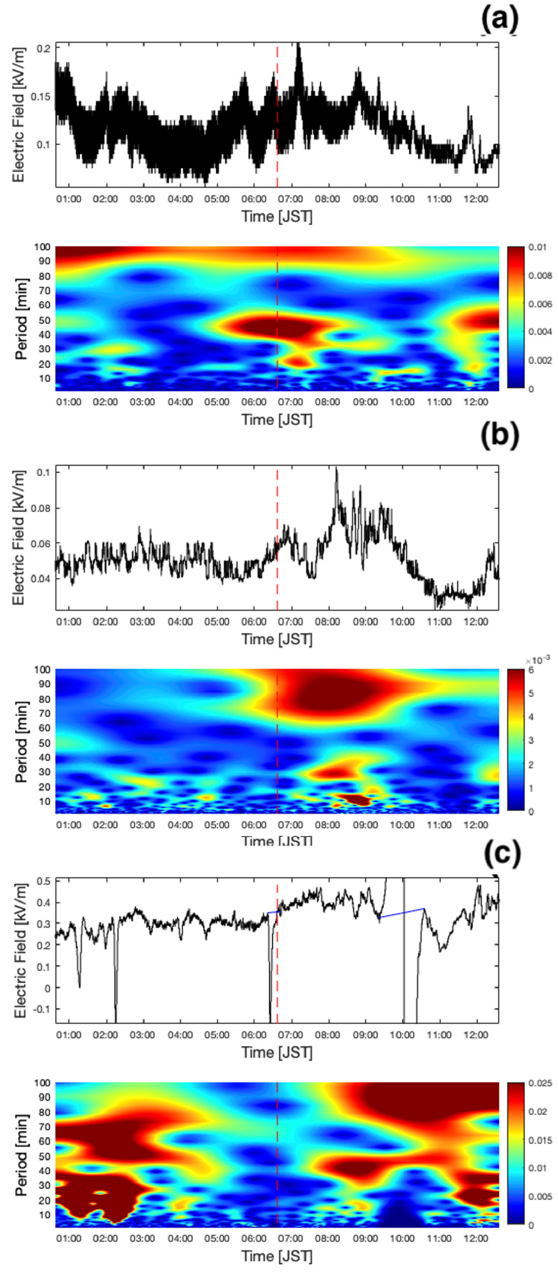
Figure 3. Time series and dynamic periodograms of the AEF with the period from up to 100 min in the interval from 6 h before to 6h after EQ1: ( a ) Chofu (CHF), ( b ) Kakioka (KAK), and ( c ) Iwaki (IWK). It was preferable for us to first consider the data at CHF (Figure 3a) because the epicenter of EQ1 was closest to the observing station of CHF and we can assume that the original agent leading to the generation of such fluctuations was likely to be around the EQ epicenter. Figure 3a suggests a global structure of three red bands (higher intensity fluctuations). The first red band with a period greater than 80 min was from 6 h before